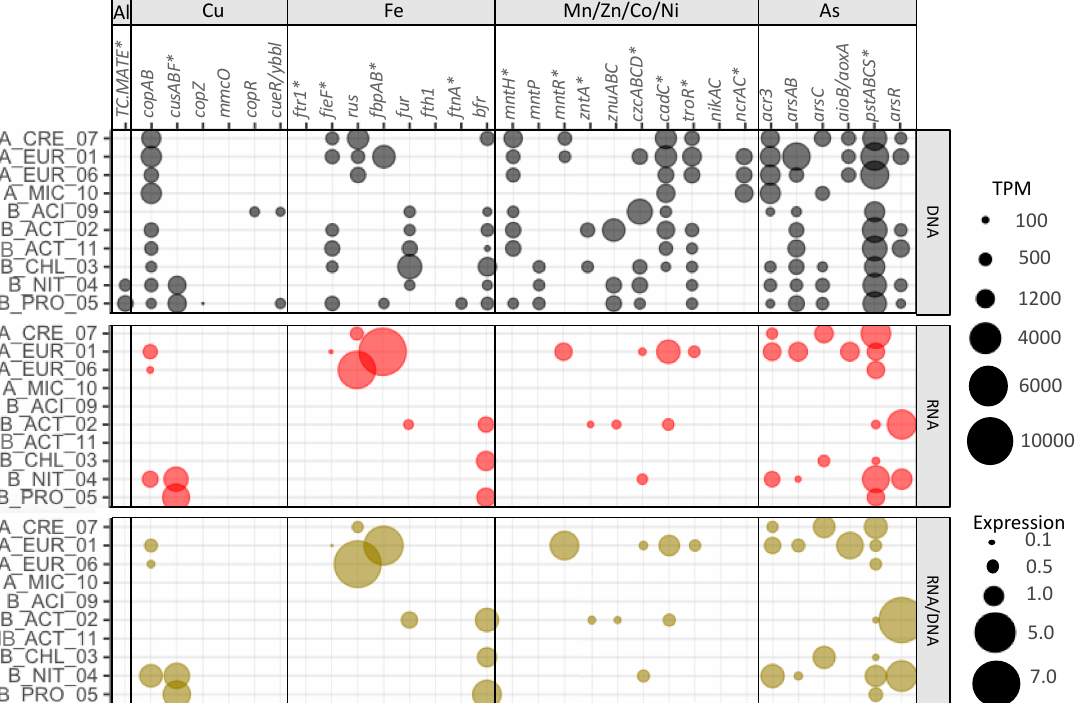
Figure 5. Normalized gene abundance (upper rows), normalized transcript abundance (middle row) and expression (lower rows) of metal-specific metal resistance genes (except with *) detected in MAGs from different phyla recovered from metagenomes of the deep layer of Cueva de la Mora (CM). Normalized gene and transcript abundances are calculated as TPM values. Expression is calculated as transcript TPM/gene TPM. Gene functions are listed in Table 3. MAG labels are clarified in Table 5.